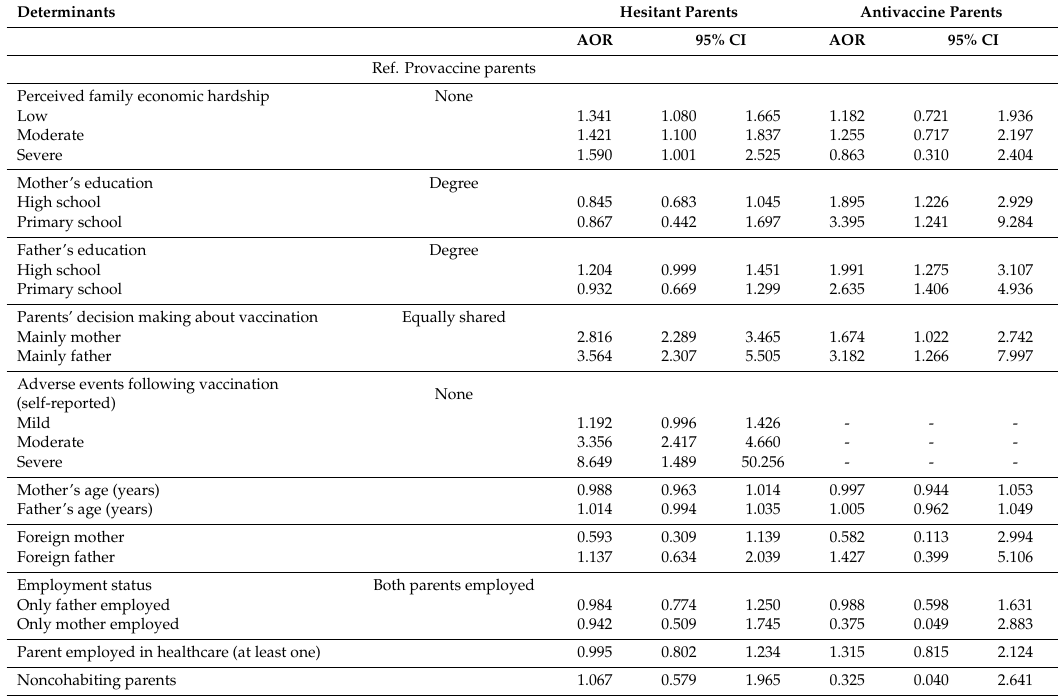
Table 2. Logistic regression. Determinants of vaccine hesitancy and outright vaccine refusal among parents. AOR = adjusted odds